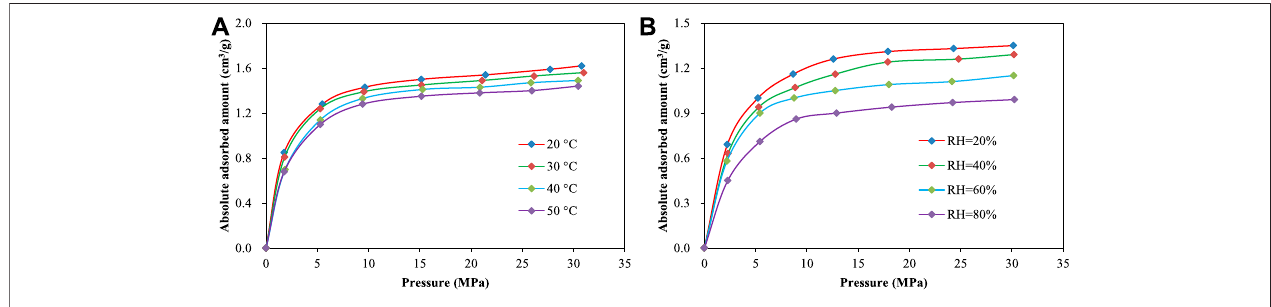
FIGURE 1 | Methane absolute adsorption isotherms at (A) different temperatures under dry condition and (B) different relative humidity levels under 20 ° C.